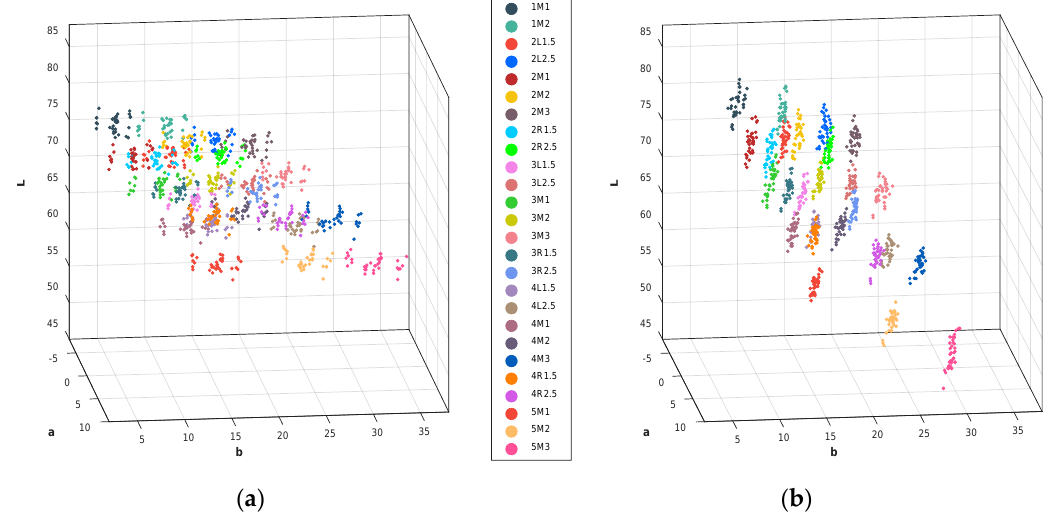
Figure 6. Colors of the Vita 3D master (3D) shade tab measured by the developed digital shade-matching device in the CIEL*a*b* color space ( a ) before color correction and ( b ) after color correction.